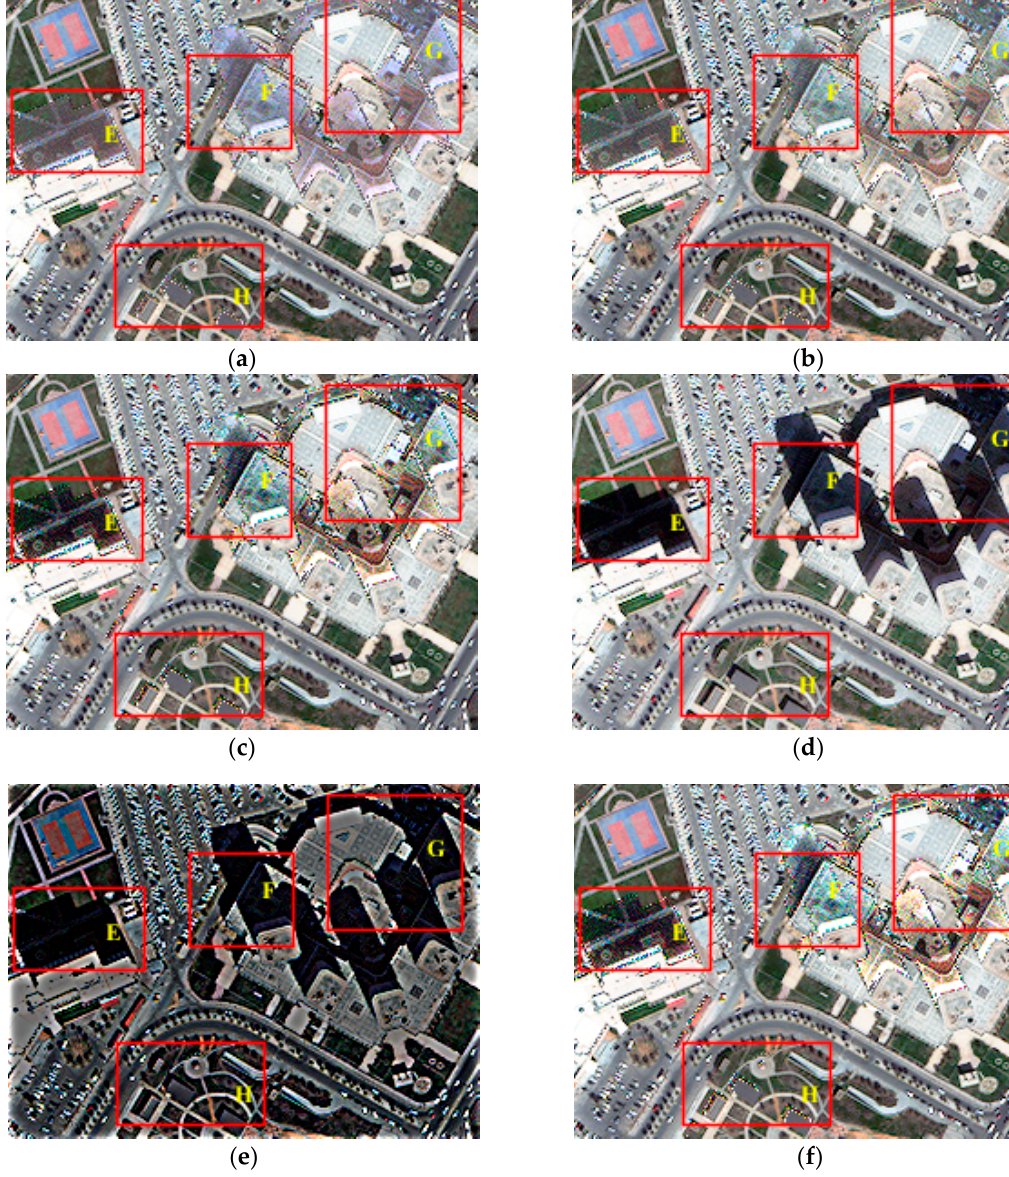
Figure 7. Shadow compensation results of various shadow compensation algorithms for the test image Tripoli-2. ( a ) IRB. ( b ) LCC. ( c ) LSCR. ( d ) MSR. ( e ) HF. ( f ) DELM.